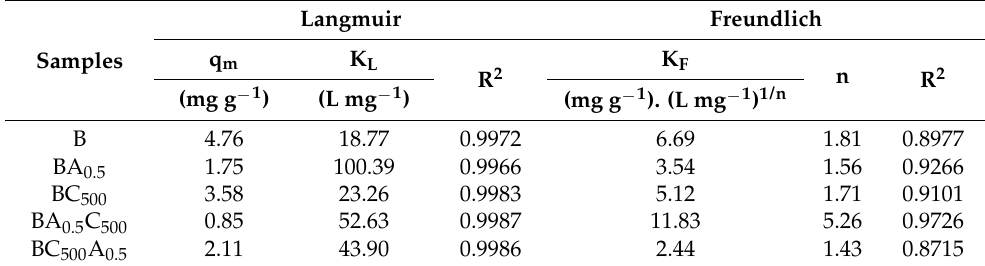
Table 5. Langmuir and Freundlich paraquat adsorption isotherm